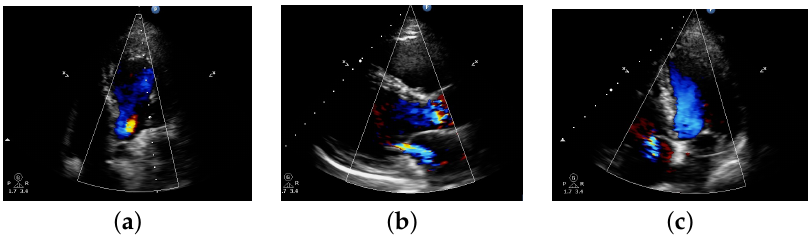
Figure 1. Diagram showing Doppler echo from the dataset of patients having ( a ) aortic regurgitation (AR), ( b ) mitral regurgitation (MR), and ( c ) tricuspid regurgitation (TR),